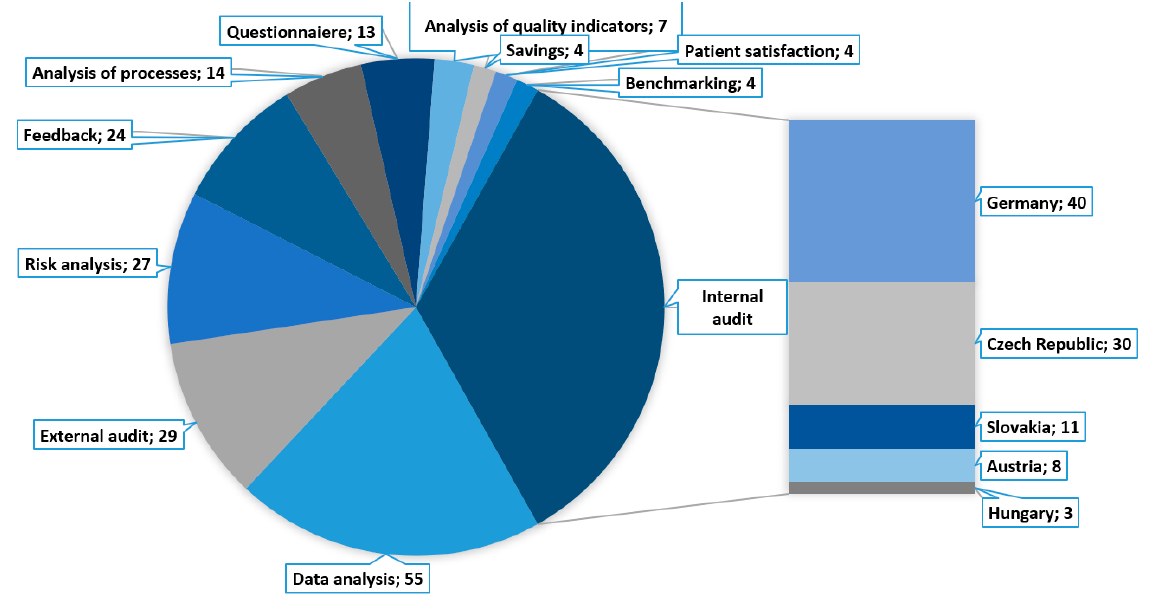
Figure 7. Most common approaches to change success assessment.